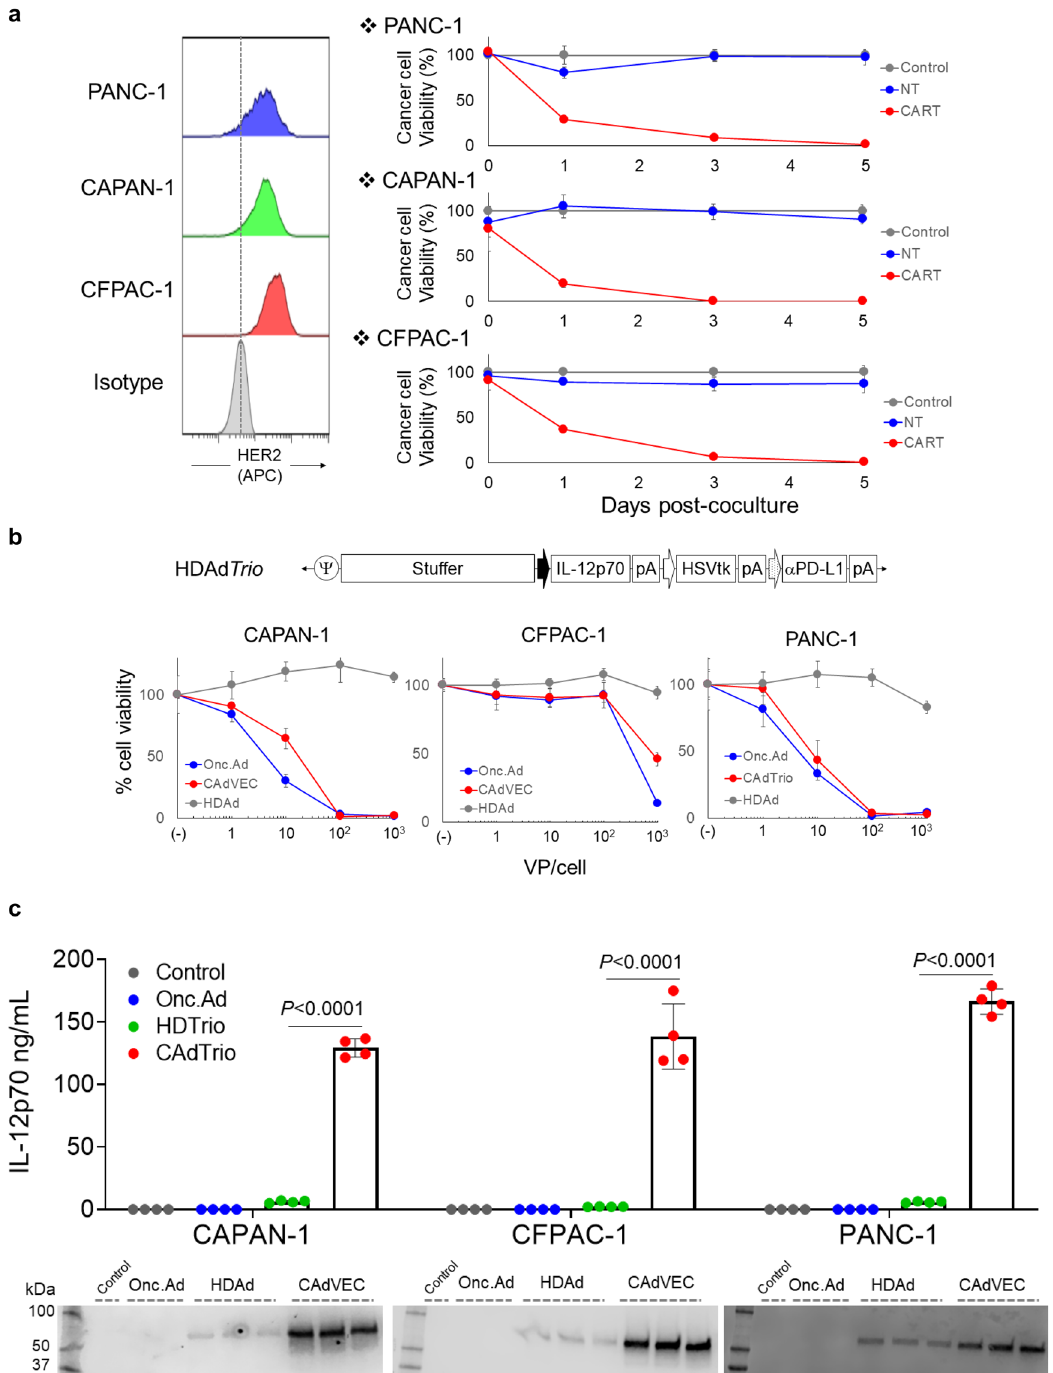
Fig. 1 HER2.CART and CAdTrio kill human PDAC lines in vitro. a HER2 expression was analyzed by fl ow cytometry on PANC-1, CAPAN-1, and CFPAC-1. Tumor cells expressing ffLuc were cultured with NTs or HER2.CARTs (E:T = 1:10). Cells were harvested 0, 1, and 5 days post coculture, and viable cancer cells were analyzed by luciferase assay ( n = 4 biologically independent samples, each time point). Data are presented as means ± SD. b Schematic structure of HDAd encoding human IL-12p70, HSVtk safety switch and PDL1 blocking antibody expression cassettes (HDAd Trio ). PANC-1, CAPAN-1, and CFPAC-1 were infected with increasing doses of HDAd Trio , OAd, or CAd Trio (OAd: HDAd = 1:1) ( n = 6 biologically independent samples). We analyzed viable cells at 96 h by MTS assay. Data are presented as means ± SD. c PANC-1, CAPAN-1, and CFPAC-1 were infected with total 10 vp/cell of HDAd Trio , OAd, or CAd Trio (OAd:HDAd = 1:1) ( n = 4 biologically independent samples). We sampled media 48 h post infection and quanti fi ed levels of IL-12p70 and PD-L1 mini-antibody by IL-12p70 ELISA assay and Western blotting for PD-L1 mini-antibody, respectively. Data are presented as means ± SD, p < 0.0001 determined by two-tailed t test ( t = 32.93, dF = 6). Statistical signi fi cance set at p < 0.05, ns > 0.05.